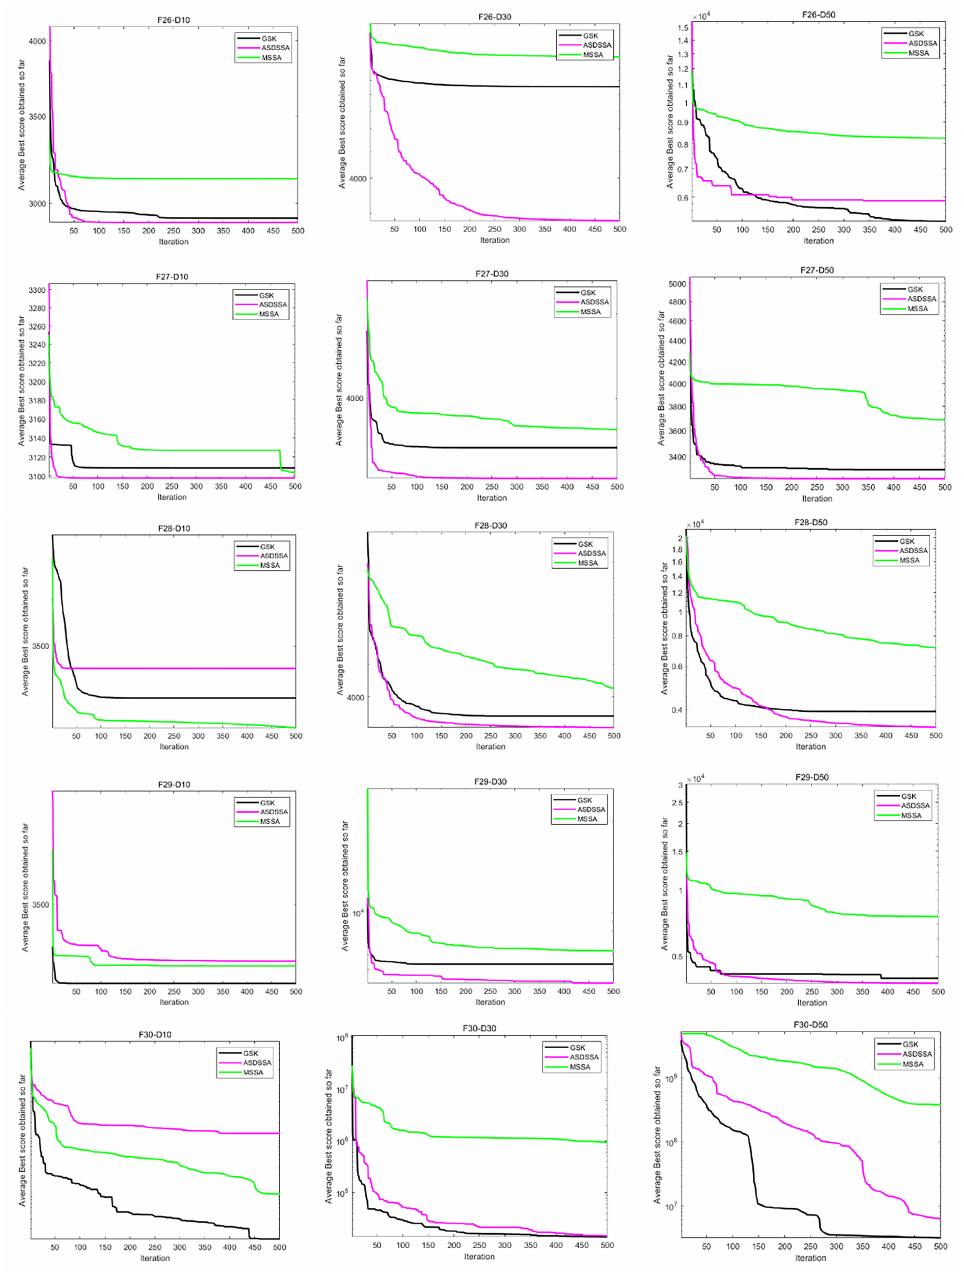
Figure 9. Convergence curves of F26–F30. Table 7. Results of ASDSSA vs.